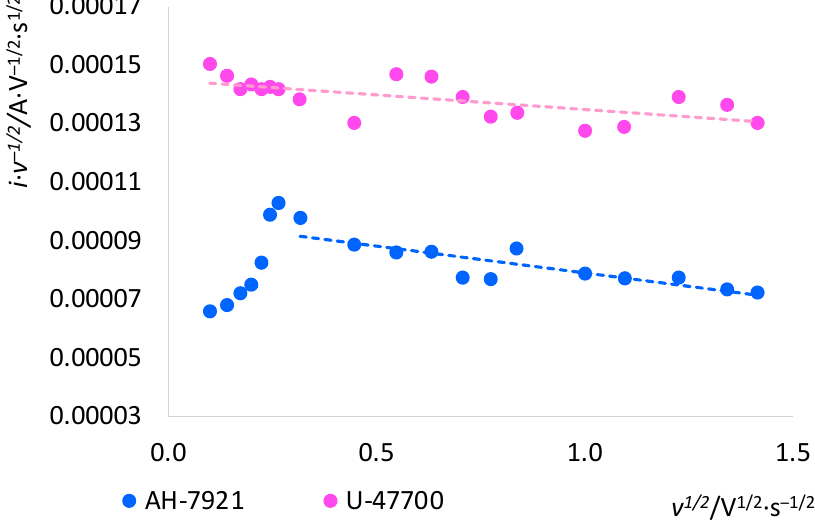
Figure 7. i · v − 1/2 vs. v 1/2 graph for the first voltammetric peak of U-47700 and for the first voltam- metric peak of AH-7921. Equations are reported in Table